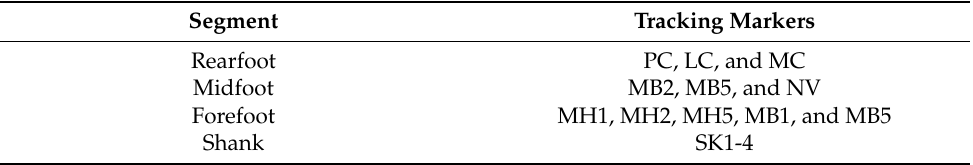
Table 1. Tracking markers for foot and shank